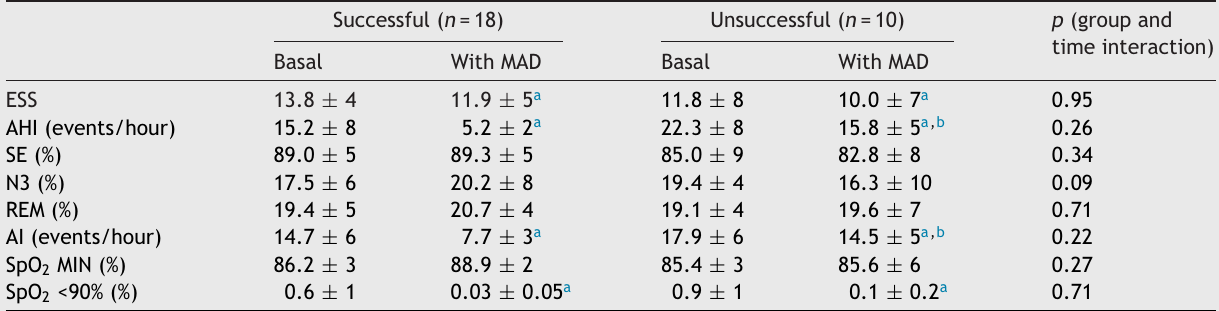
Comparison of the Epworth Sleepiness Scale and polysomnography parameters between patients showing successful and unsuccessful treatment with MAD at baseline and 120 days after MAD